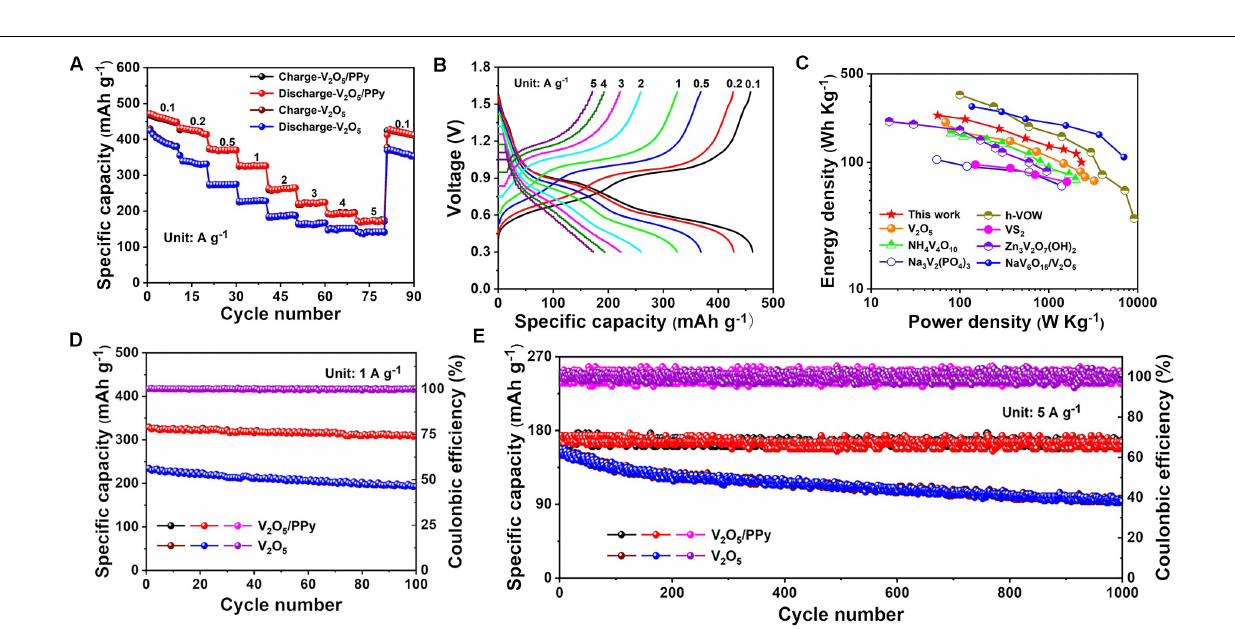
FIGURE 2 | Electrochemical performance of V 2 O 5 /PPy composites cathode in aqueous ZIBs. (A) Rate performance in comparison to pristine V 2 O 5 . (B) Voltage profile plots at different current rates. (C) Ragone plot. (D) Cycling performance at 1A g - 1 and (E) Long-term cycling performance at 5A g - 1 , in comparison to pristine V 2 O 5